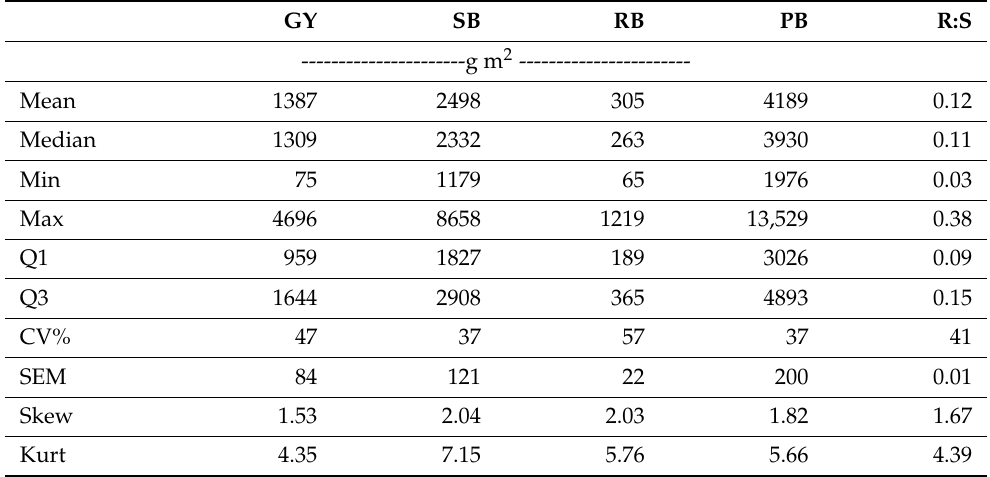
Table 2. Summary statistics (min = minimum: max = maximum; Q1 = 1st quartile; Q3 = 3rd quartile; CV = coefficient of variation; SEM = standard mean error; skew = skewness; kurt = kurtosis) for grain yield (GY), selected morphological variables (SB: shoot biomass, RB: root biomass, PB: total plant biomass, R:S: root to shoot) for the 100 wheat genotypes grown in the field and in the glasshouse, and across water